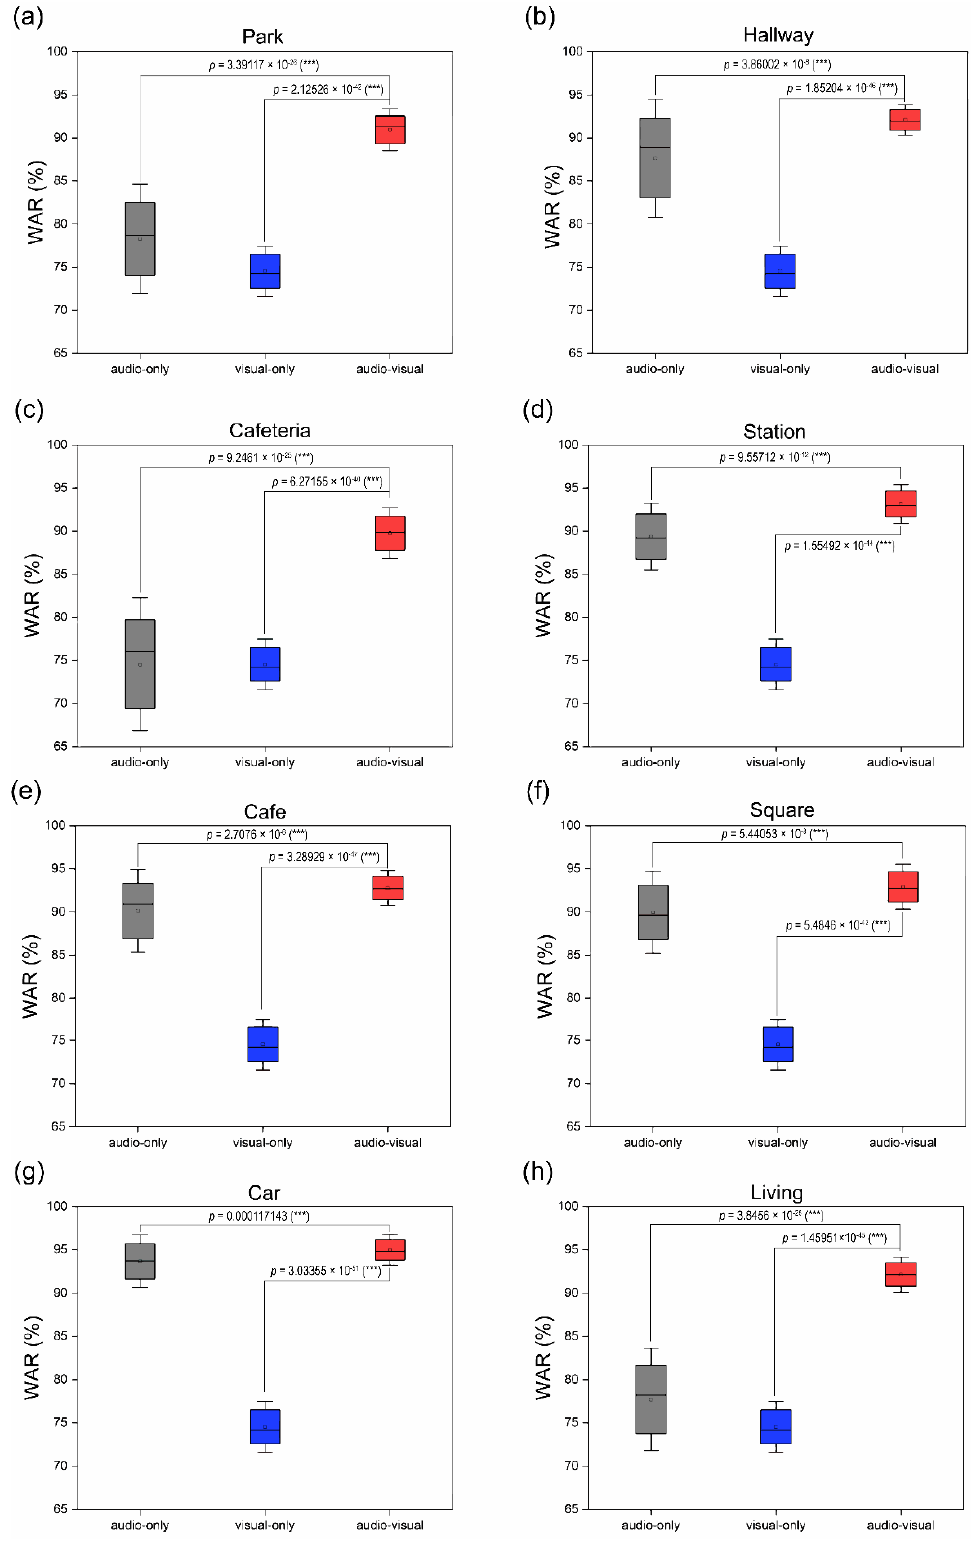
Figure 13. Best average recognition accuracy rates under eight noise environments. Error bars represent standard deviation. Asterisks represent statistical significance-based t -tests between each group (* for p < 0.05, ** for p < 0.01, *** for p < 0.001). The gray (single-modal recognition) line represents the audio recognition result, the blue (single-modal recognition) line represents the visual recognition result, and the red (multimodal recognition) line represents the audio-visual recognition